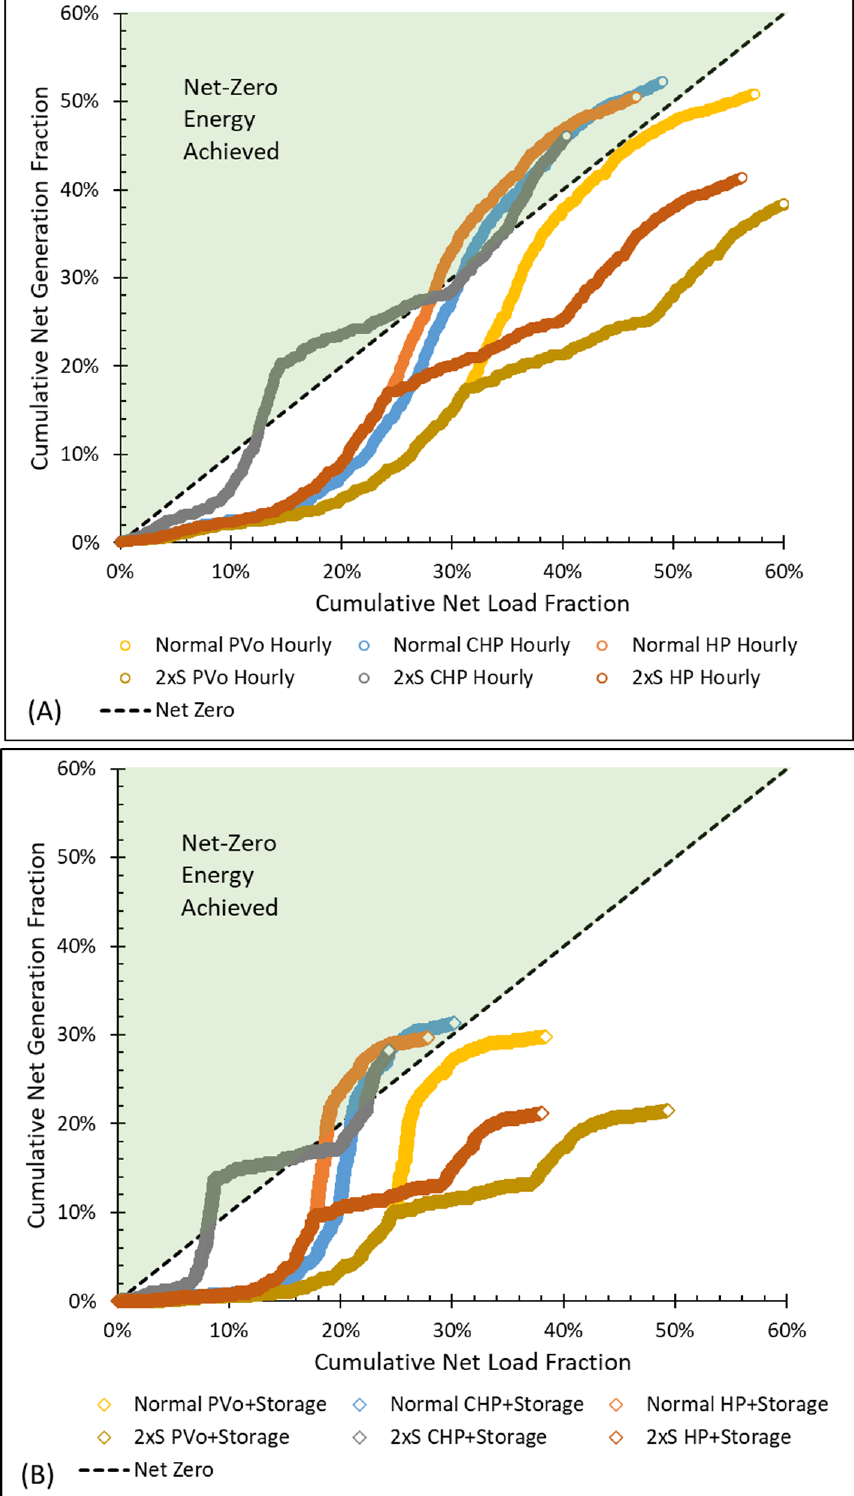
Figure 6. NWC cumulative net load/generation plots. Data of each scenario is summed hour-to-hour separately for each carrier (natural gas and electric) based on whether the net energy demand is positive (net load) or negative (net generation). Plot values are normalized as a fraction of total an- nual load and generation for PV only (PVo), PV/HP, and PV/CHP with both Normal and 2× Summer (2×S) loads. Plot ( A ) is the six baseline energy scenarios while plot ( B ) includes energy storage. The cumulative traces sum the dynamic energy flow to and from the grid and demonstrate a heavy dependence on the grid for all scenarios. A final position above the net-zero dashed line indicates net-zero energy status has been achieved on an annual basis. The farther the end point is above the dashed line, the greater the net-zero energy margin. The farther the final point from the plot origin (0,0), the greater the energy infrastructure dependence. Implementing 10,000 kWh of electrical stor- age (~30% of average daily load) cuts the grid interaction/dependence in half for both net generation exported energy and net load imported energy. There are two key results on display in Figure 6. The first key result is that if the trace of cumulative hourly summed energy ends above the dashed line, then net-zero energy status has been achieved on an annual basis. The further the end point is above this dashed line, the greater the net-zero energy margin. The second key result is the distance from